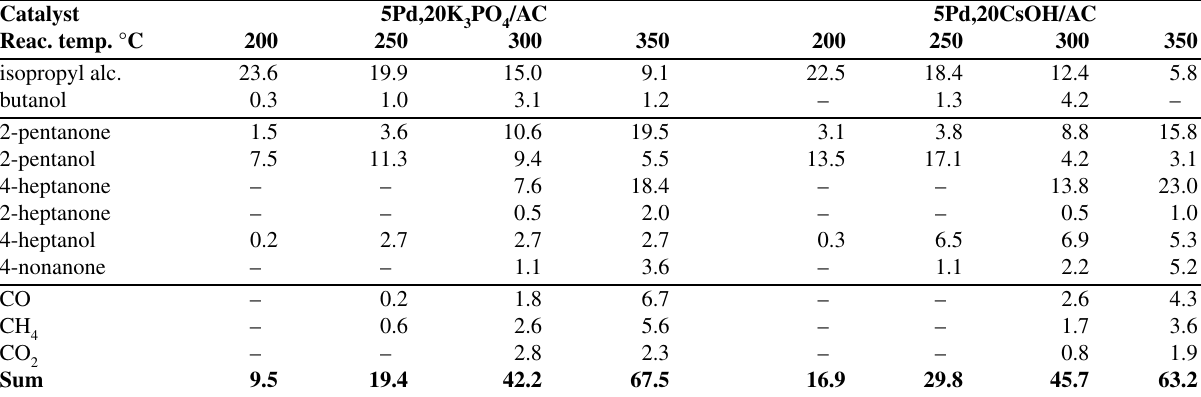
Table 2. Yields (wt%) of main products obtained in hydrogen stream. Catalyst Reac. temp. °C isopropyl